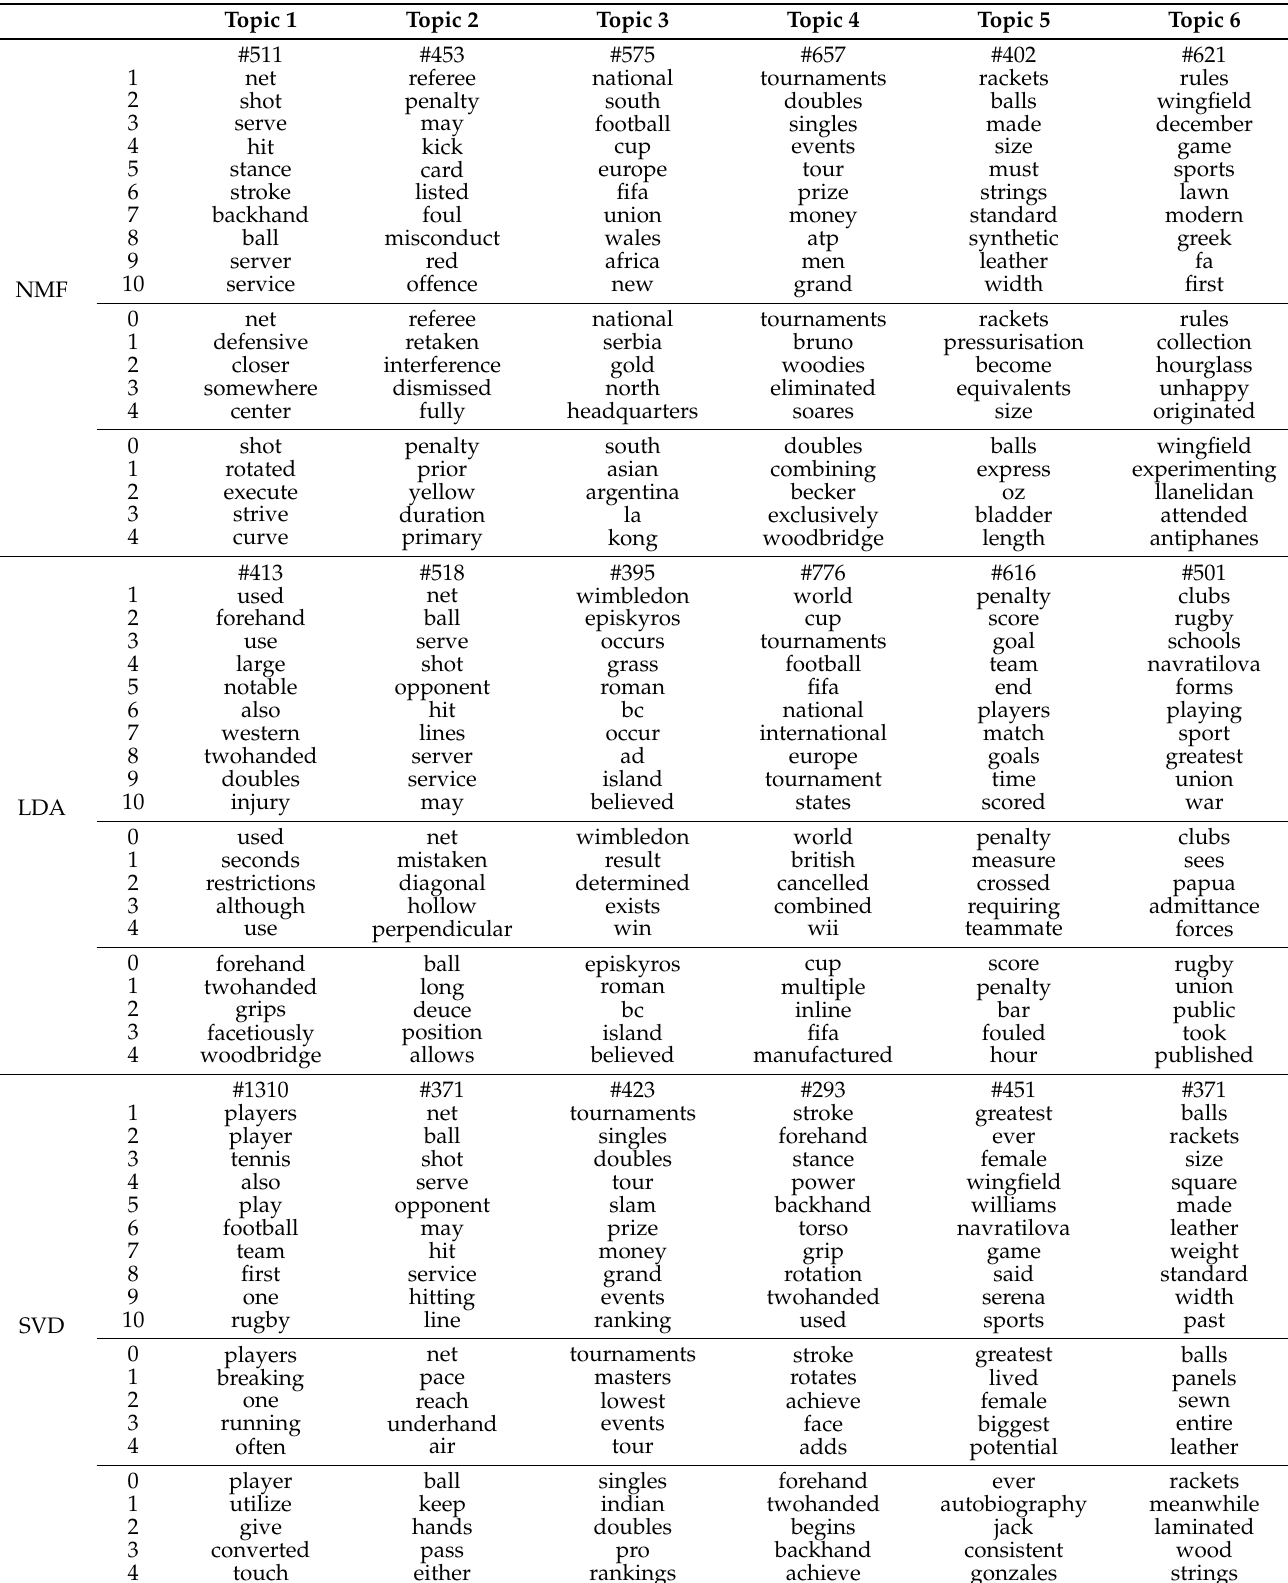
Table A5. For each evaluated matrix factorization method we display the top 10 words for each topic and the 5 most similar words based on cosine similarity for the 2 top words from each